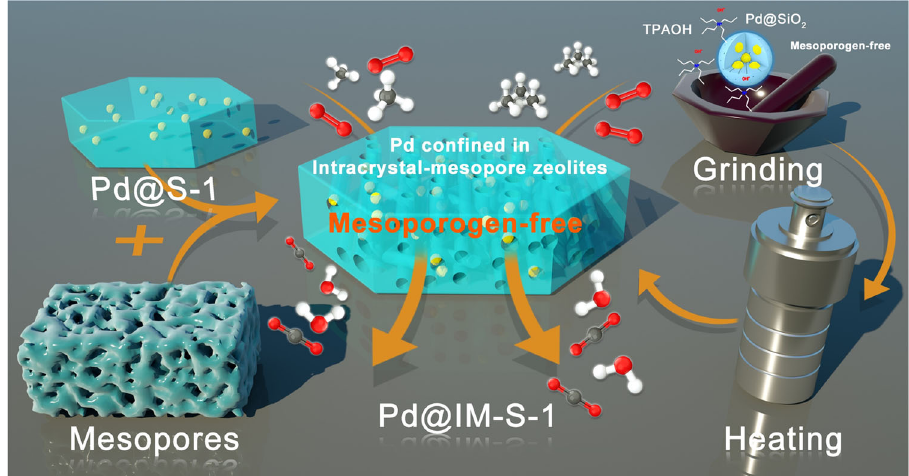
Fig. 1 Schematic illustration for the synthesis of Pd@IM-S-1 and application for deep oxidation of light alkanes. Pd@IM-S-1 was synthesized via the two- step mesoporogen-free in situ